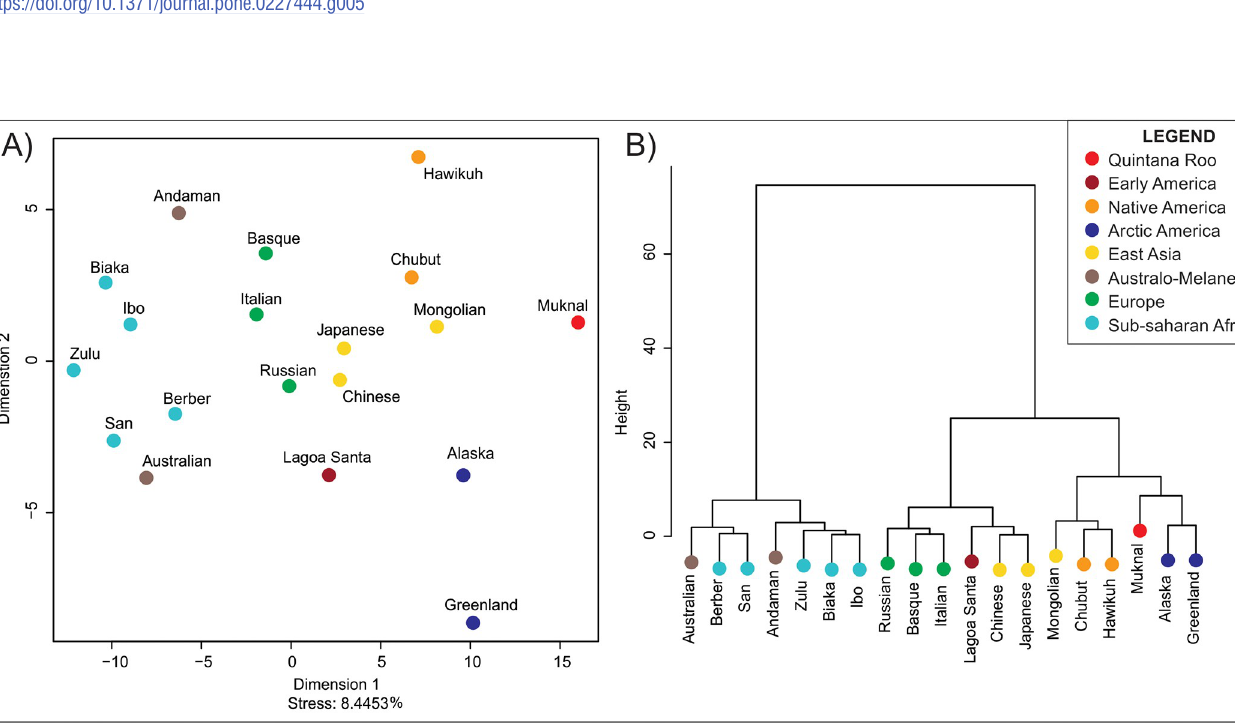
Fig 5. Morphological affinities between Las Palmas and reference series according to Mahalanobis distances of the first five Principal components. A) Multidimensional Scaling. B) Ward’s Cluster.